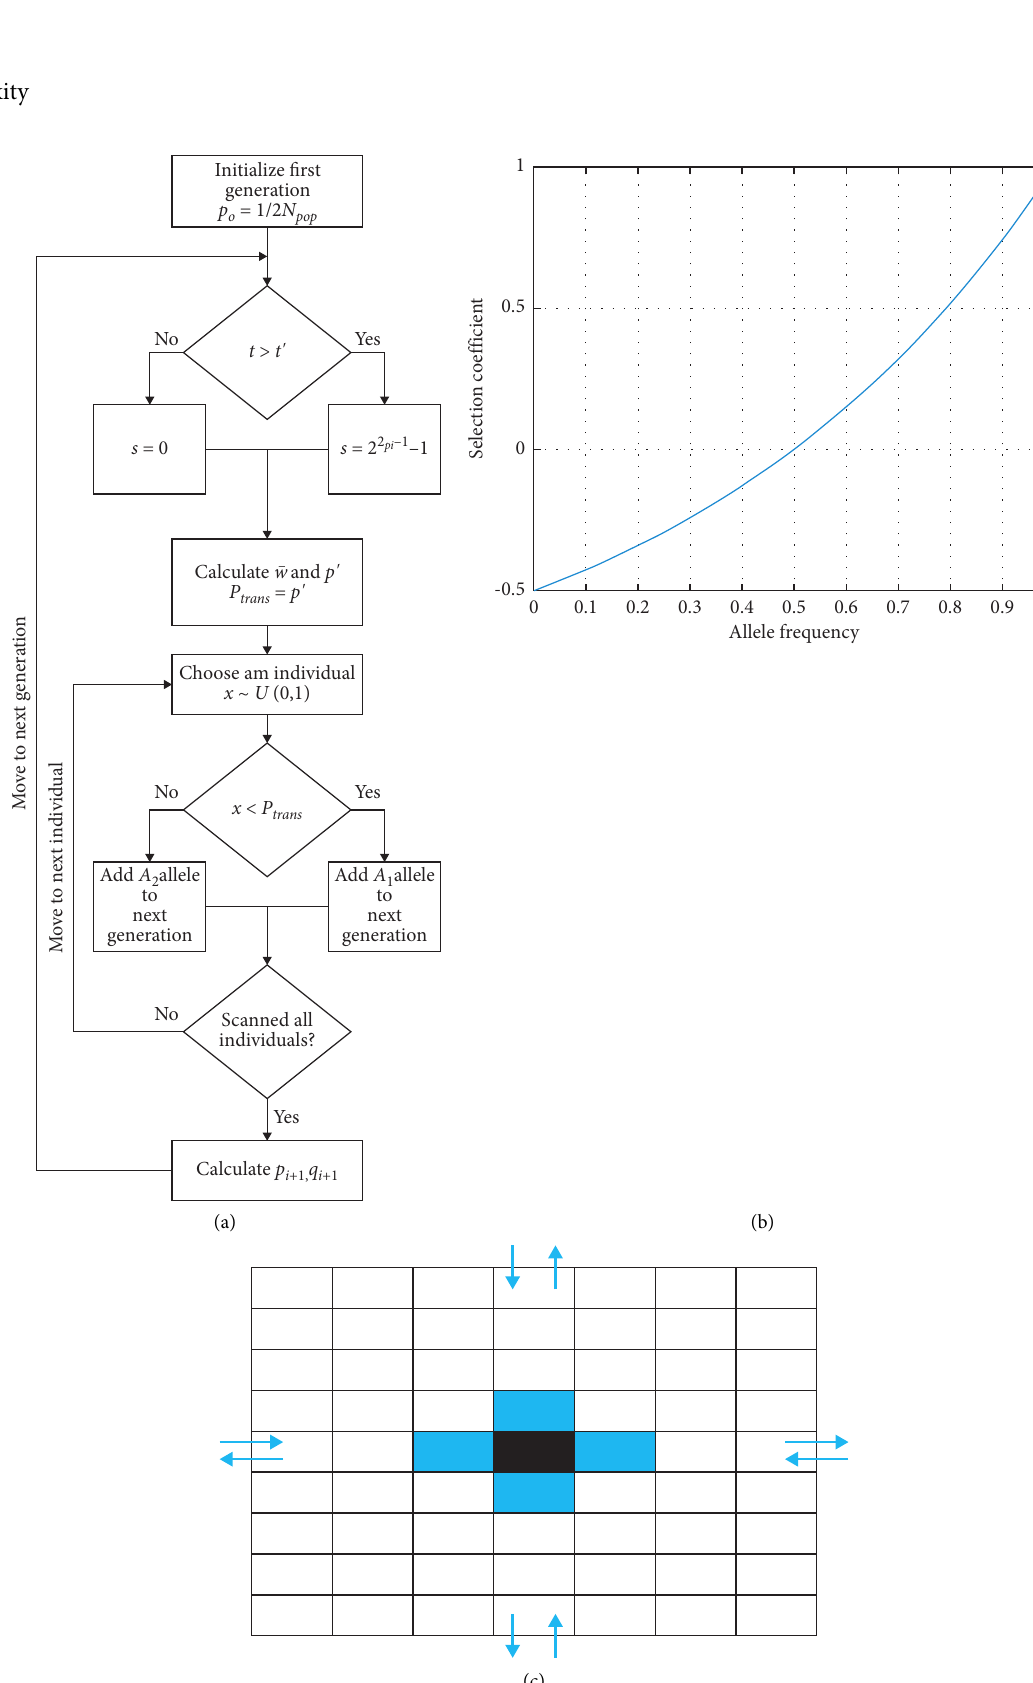
Figure 1: (a) An individual-based model for the emergence of a positive frequency dependent allele. (b) Selection coefficient of the said allele is negative when it is rare in the population, and is positive when the allele becomes more frequent within the population. (c) An extension of the model to a spatial grid with periodic boundary conditions where migration happens between residents of any focal patch and the surrounding patches in its von Neumann